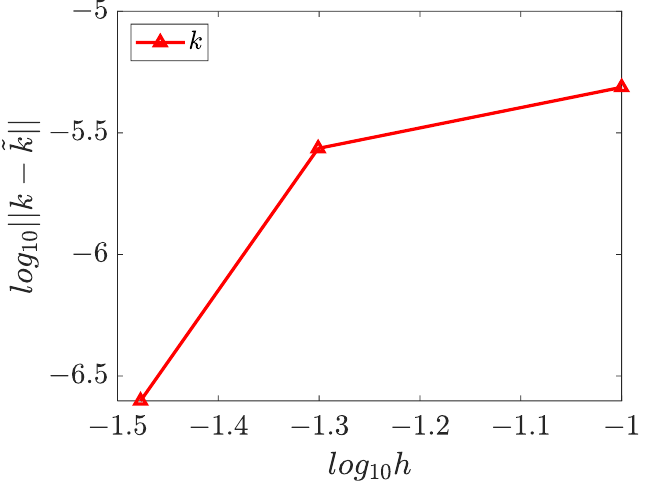
Figure 5. Variation of wave number k with iteration steps for the 1D constant parameter identifica- tion problem.